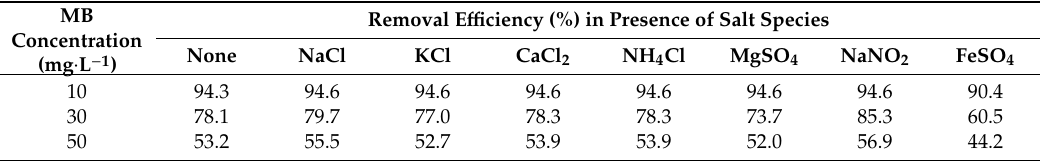
Table 6. E ff ect of salt species on the removal e ffi ciency (%) of MB at 25 ◦ C, t = 30